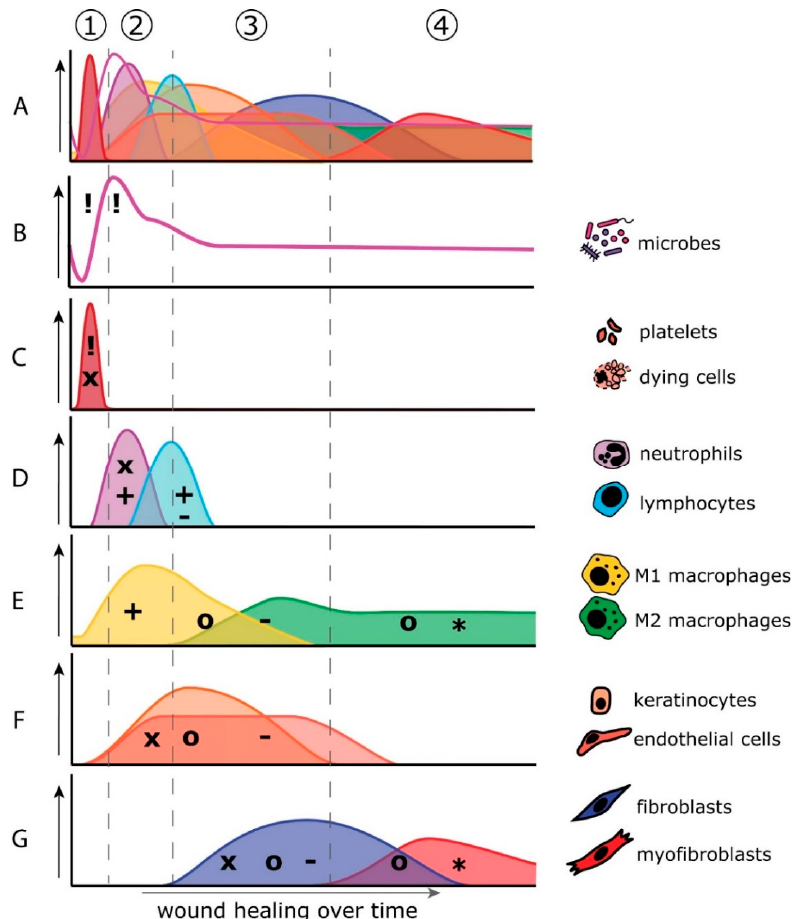
Figure 4. Overlapping phases of wound healing and relative contribution of cells, microbiome, and key molecules to wound healing over time. Wound healing is a well-orchestrated process that involves various cells and secreted factors. The separate phases of wound healing overlap in time and space and any change in one of the mediators (being cells or secreted molecules) affect healing outcome ( A ). Cell types and microbes involved in the stages of the wound healing process are shown individually ( B – G ) on the right side of the color coordinated graphs. (1) Hemostasis phase: minutes after wounding, the wound is quickly colonized by opportunistic and potentially pathogenic microorganisms releasing pathogen-associated molecular patterns (PAMPs; !) into the wound bed. Platelets and dying cells ( A ) release chemokines (x) and damage-associated molecular patterns (DAMPs; !) that attract immune cells ( C ). (2) Inflammation phase: minutes to hours after wounding, neutrophils are the first immune cell type to enter the wound bed. Neutrophils release chemokines (x) and proinflammatory cytokines (+) that attract and activate other immune cells such as lymphocytes and M1 macrophages ( D , E ). Macrophages contribute to proinflammatory cytokine secretion (+) and release growth factors (o) to stimulate tissue regeneration ( E ). (3) Proliferation phase: hours to days after wounding, keratinocytes, endothelial cells, and fibroblasts repopulate the granulation tissue via migration, proliferation, and differentiation in response to secreted chemokines (x) and growth factors (o) ( F , G ). Once the wound is closed, the resident cells secrete anti-inflammatory cyto- kines (-) to dampen the immune response ( F , G ). (4) Remodeling phase: weeks to months after wounding, (myo)fibroblasts ( G ), and M2 macrophages ( E ) that still reside in the wound bed remodel the extracellular matrix via the secretion of matrix proteins, matrix metalloproteinases (MMPs; *), and tissue inhibitors of metalloproteases (TIMPs; *).